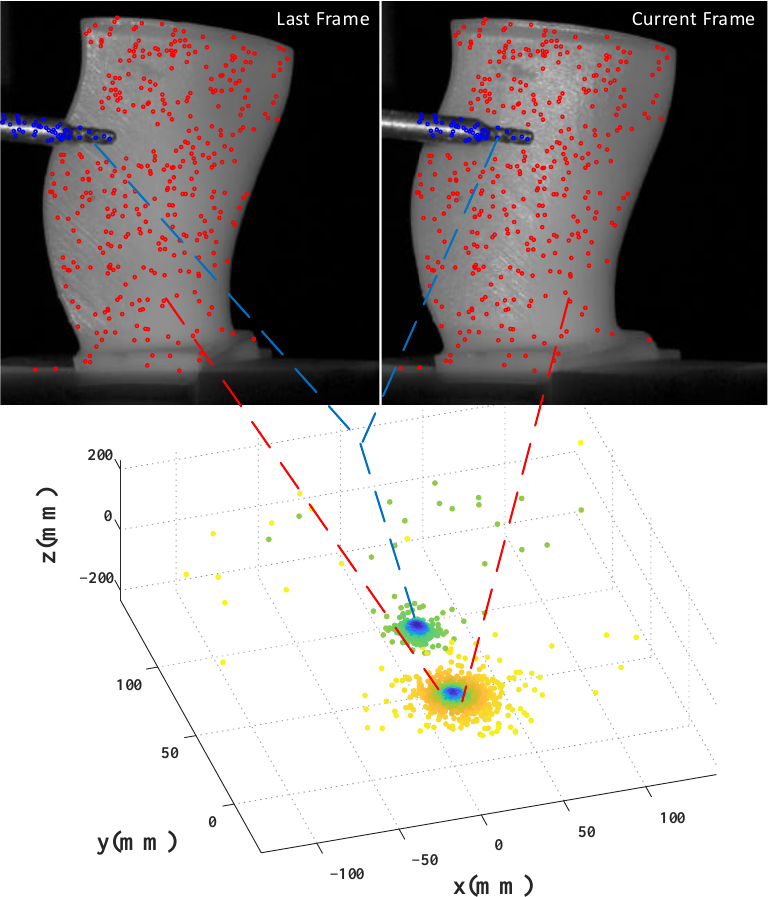
Figure 4. The results of segmentation and clustering. In the grayscale images, the last and current frame represent two adjacent frames and the circles indicate the matched points. The circles with different colors indicate that the feature points are located on different objects. In the three-dimensional pose parameter space, the translation vectors with the real scale are demonstrated. The shade of the color means the density is different. These two cluster centers correspond to two objects with different motions.